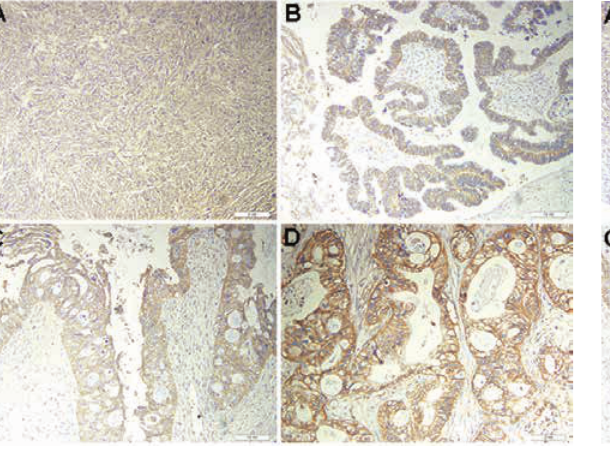
Figure 1: Representative immunohistochemical results of EpCAM in human normal ovary and epithelial ovarian carcinoma tissue sections. (A) Mild staining of EpCMA in normal ovary tissue. (B) Epithelia ovarian carcinoma tissue with weak positive (+) of EpCAM. (C) Epithelia ovarian carcinoma tissue with moderate positive (++) of EpCAM. (D) Epithelia ovarian carcinoma tissue with strong positive (+++) of EpCAM